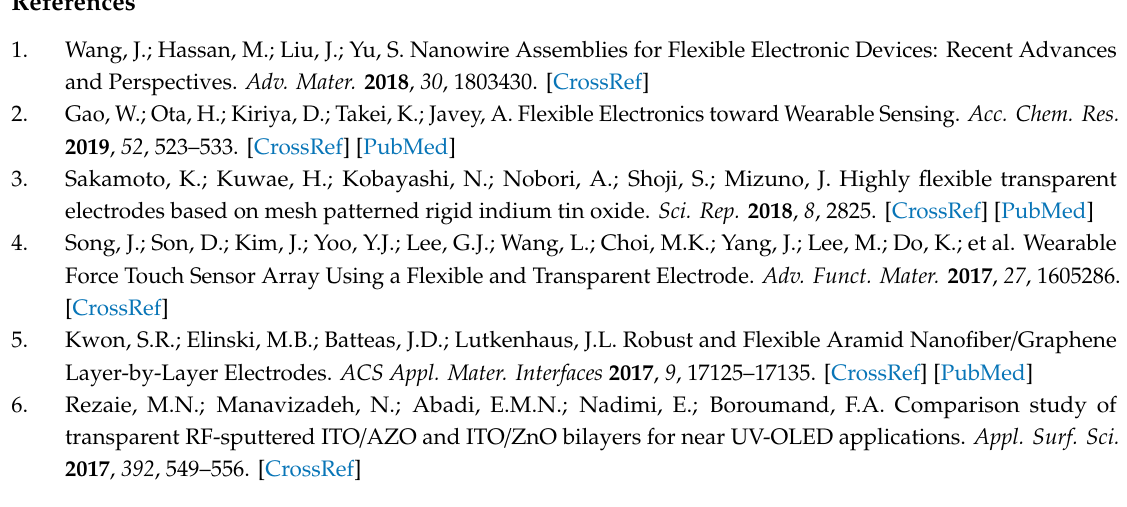
Figure 6. J–V characteristics of PTB7:PC 71 BM organic solar cells constructed at the center and edge of silver-nanowire-embedded flexible electrodes with